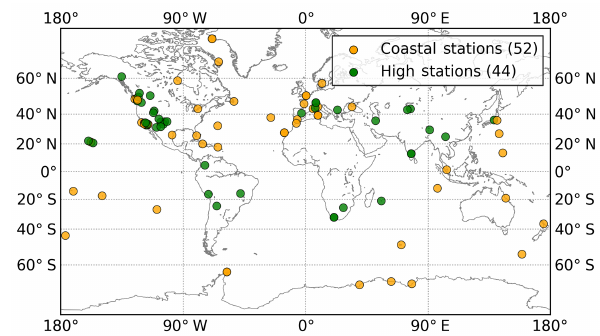
Figure 3. Location of the stations that were selected for coastal (or- ange) and high stations